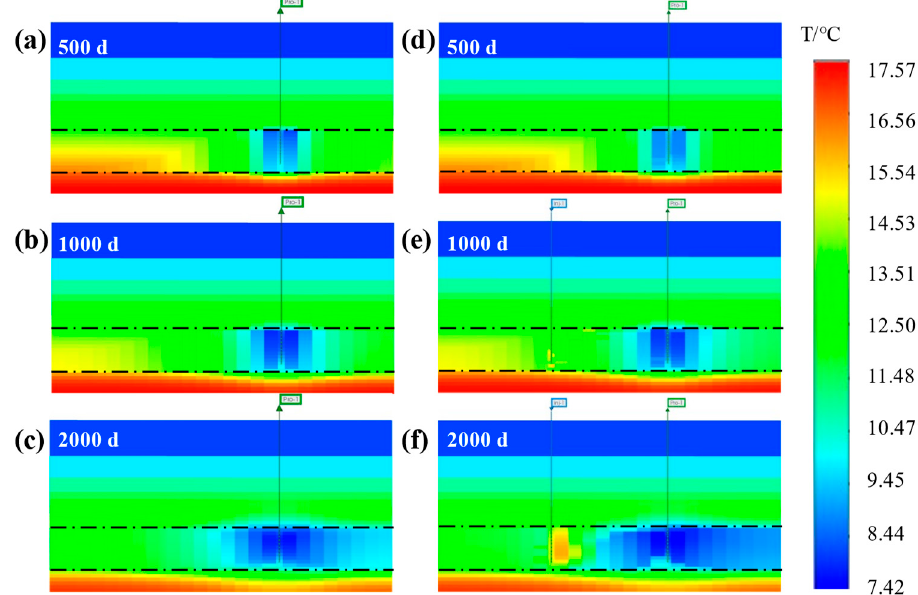
Figure 6. Evolution of T after 500 days, 1000 days, 2000 days (( a – c ) for Case A and ( d – f ) for Case B).